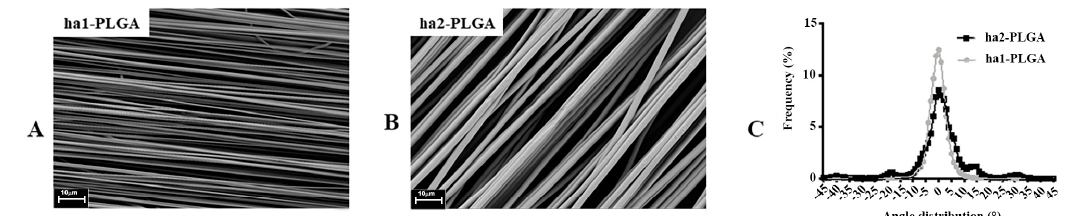
Figure 1. Morphological characteristics of the electrospun PLGA microfibers. ( A , B ) SEM micrographs of PLGA with 1.27 ± 0.11 µ m (ha1-PLGA) and 2.5 ± 0.27 µ m (ha2-PLGA) highly aligned fibers showing defect-free fleeces (n = 3 for each type of fleece). Scale bars = 10 µ m. ( C ) Frequency distribution of fiber orientation within ha1- and ha2-PLGA fleeces. Fibers of both PLGA fleeces show a sharp Gaussian curve with an orientation angle mainly ranged between − 10 ◦ to + 10 ◦ with a statistically significant high fiber alignment in the case of the fibers with small fiber diameter size (ha1-PLGA, p < 0.05) (n = 3 for each type of fleece).